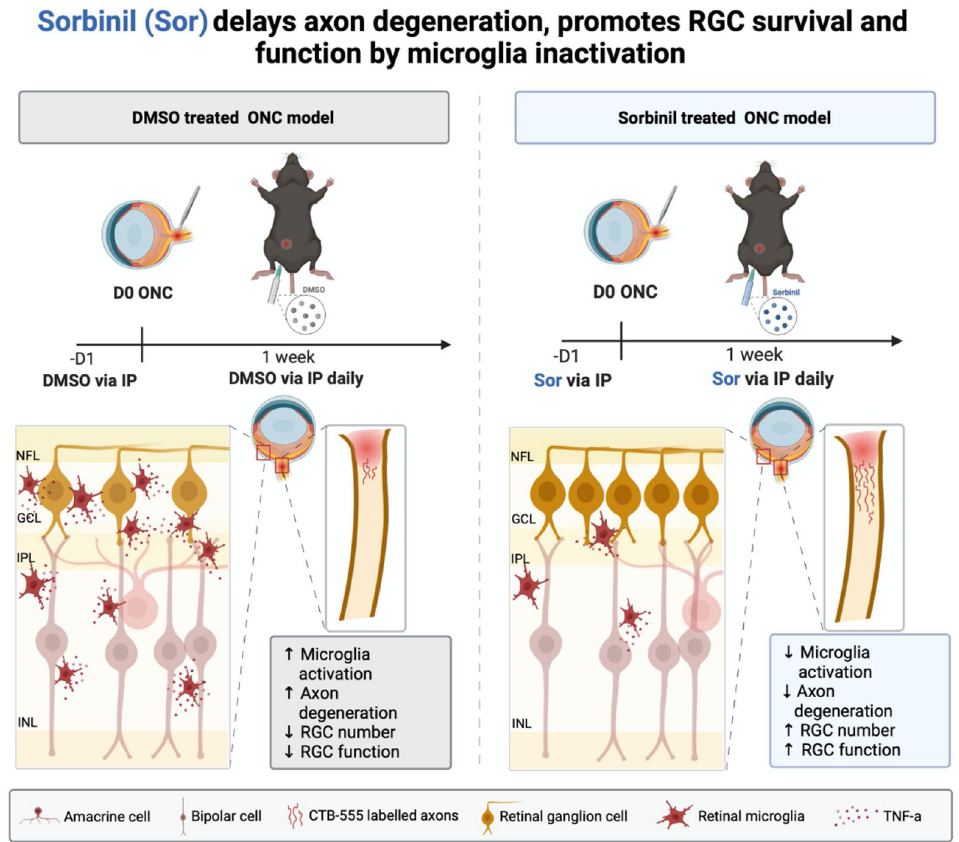
Figure 5. Model of AR-dependent regulation of microglia-RGC interaction. Optic nerve crush induces RMG distribution and TNF-α secretion in the retina and optic nerve, leading to RGC loss and axon degeneration. Daily treatment with Sorbinil for one week suppresses RMG infiltration and TNF-α secretion, which increases RGC survival and delays axon degeneration. The graphic was created with